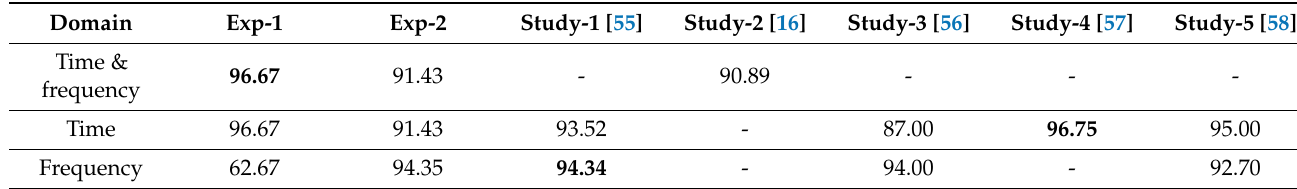
Table 11. Average detection accuracy (%) for two evaluations of experimental data (Exp-1 and Exp-2) in comparison with reported results in the literature. The accuracies are given for the combination of time and frequency domain features and also for time and frequency separately.